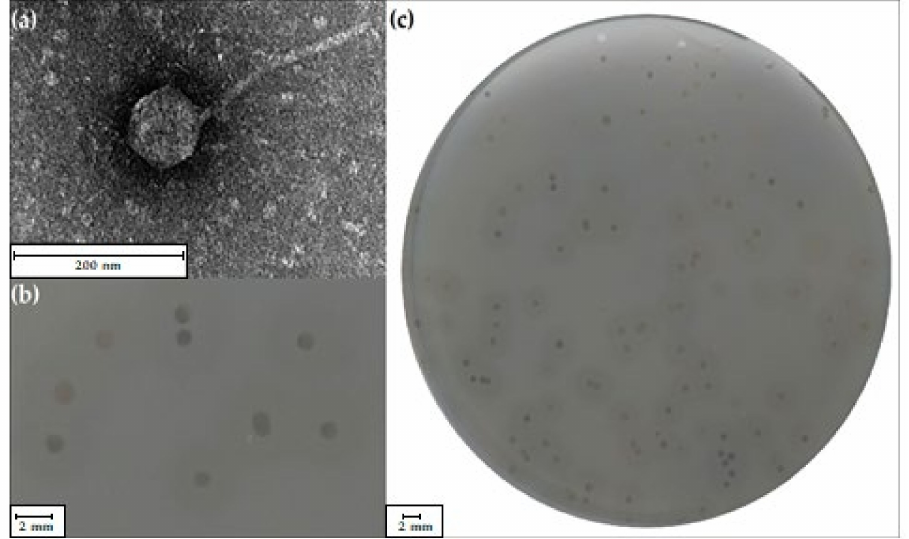
Figure 1. Characteristics of the virion ( a ) and plaques ( b , c ) of vB_SspS_KASIA. The scale bar in the transmission electron microscopy (TEM) image represents 200 nm. The scale bar in ( b ) and ( c ) images represents 2